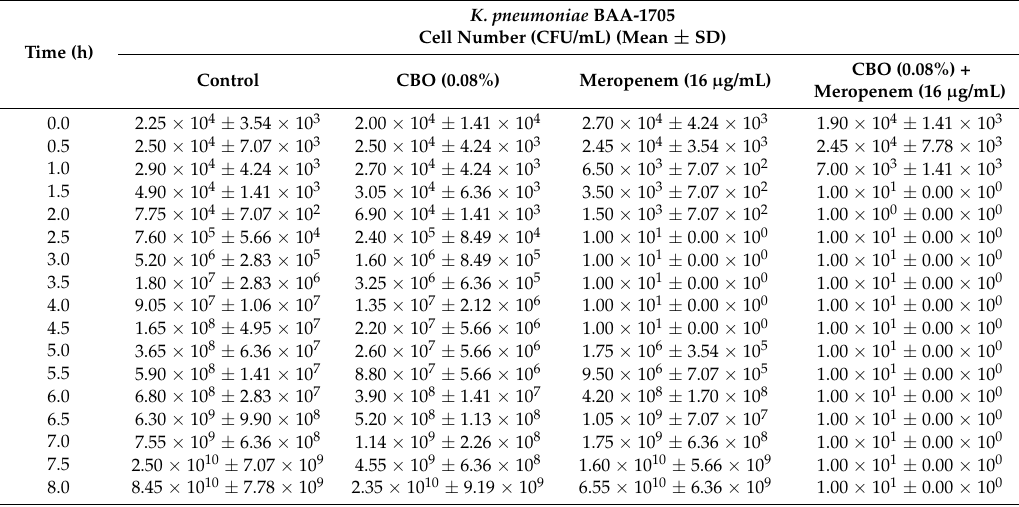
Table A2. Raw data of time kill analysis at 30 min interval for 8 h.